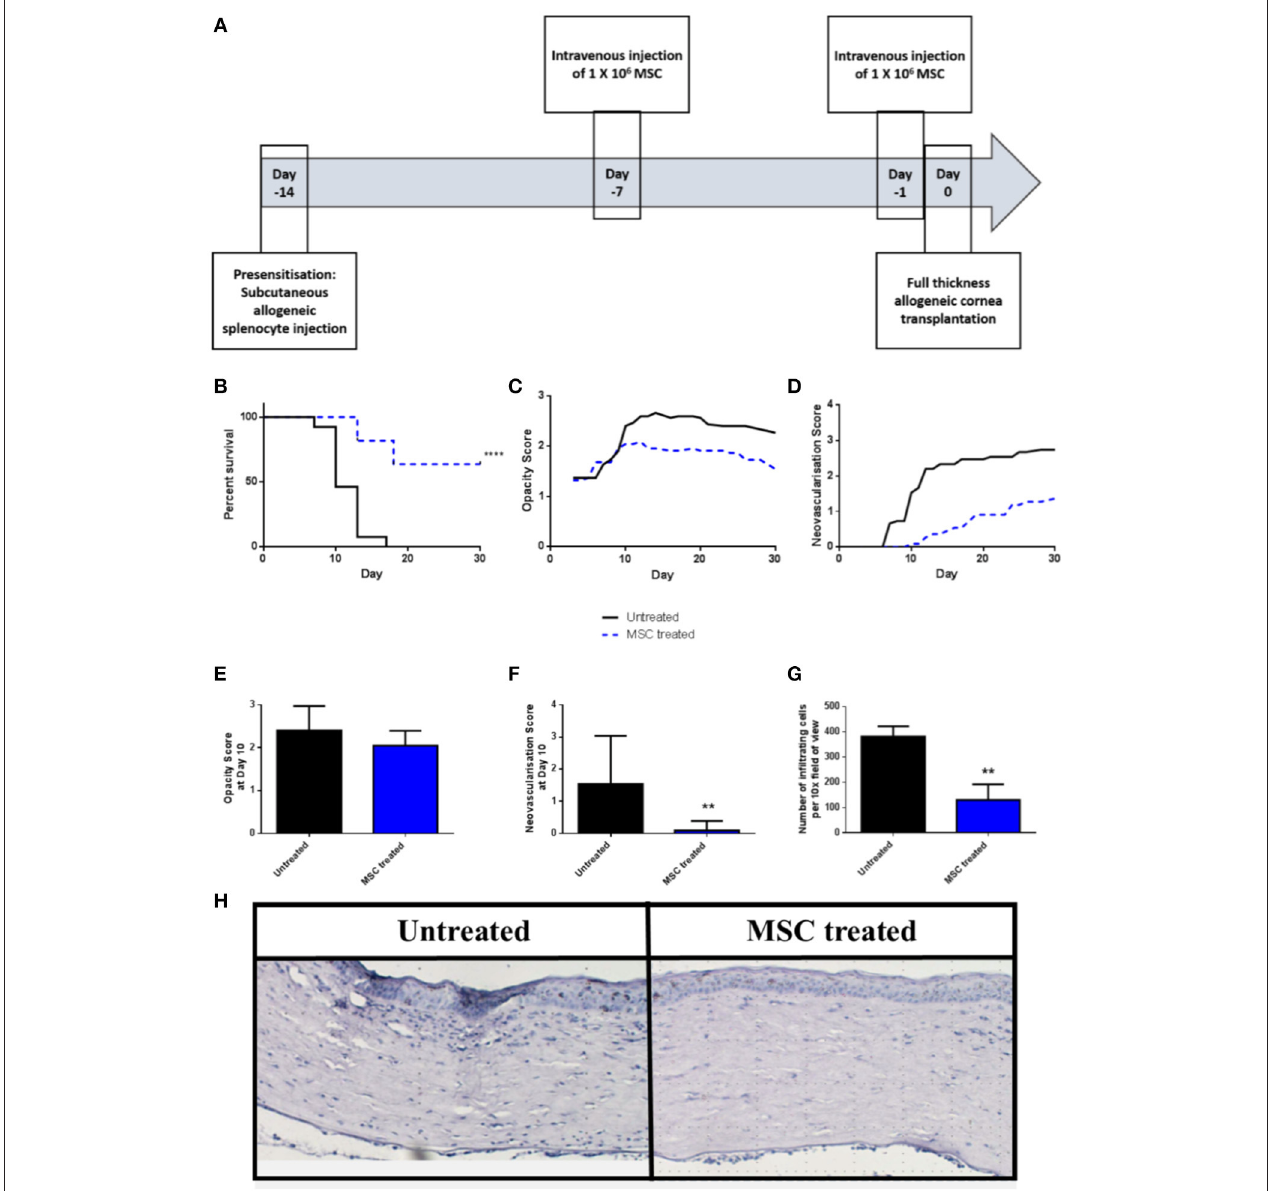
FIGURE 2 | Third-party allo-MSC are capable of prolonging rejection-free corneal allograft survival in pre-sensitized recipients. (A) Schematic representation of administration of third-party allo-MSC in the pre-sensitized high-risk rat corneal transplant model. (B) Kaplan-Meier curves demonstrating rejection-free survival of pre-sensitized Lewis recipients of DA corneas that received third-party allo-MSC injections (MSC-treated, n = 13; blue dashed line) or vehicle injections (Untreated, n = 11; black line) up to 30 days post-transplant. (C,D) Trend-lines for corneal allograft opacity scores (C) and neovascularisation scores of the two groups of pre-sensitized corneal transplant recipients up to day 30 post-transplant. (E–G) Corneal allograft opacity scores (E) , neovascularisation scores (F) and number of corneal infiltrating cells per 10X field (G) on day 10 post-transplant for untreated (black bar) and MSC treated (blue bar) groups. All data are presented as mean ± SEM. (H) Representative examples of H&E stained sections of corneal allografts of untreated and MSC-treated pre-sensitized Lewis rats at day 10 post-transplant. Statistical significance was determined using a Log-rank (Mantel-Cox) test or one-tailed Student’s t -test or as appropriate ** p < 0.01, **** p <